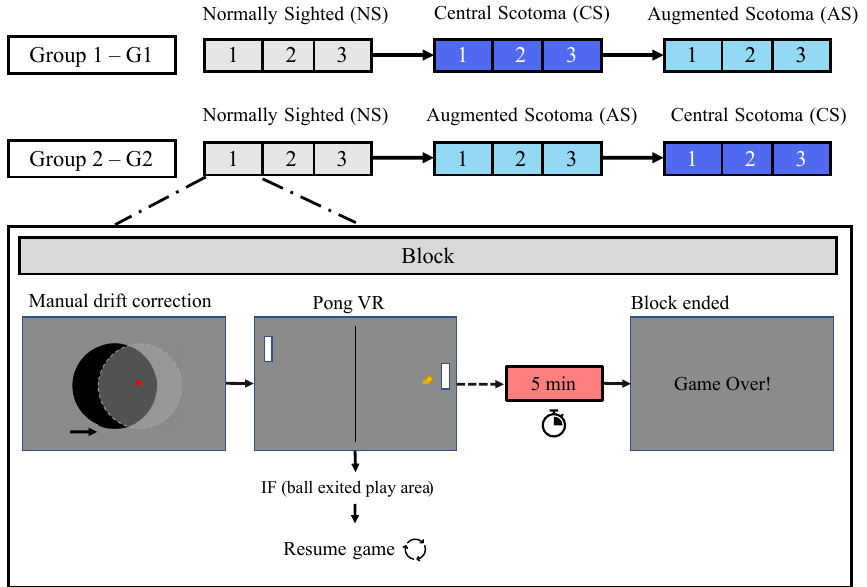
Figure 3. Scheme of the experimental procedure. Participants were divided into two groups (G1 and G2). Both groups initiated playing the Pong game under normal vision conditions (normally sighted, NS). The difference between groups was defined by the order by which the scotoma (CS) and augmented scotoma (AS) simulations were presented. In group 1, the scotoma simulation followed the augmentation, in group 2 the opposite. During each condition, three blocks (1, 2, and 3) were tested. Each block was the same for all conditions. It started with a manual drift correction followed by a 5-min timer playtime. During the game, the ball could have exited the play area. In that case, the timer was frozen and the game re-started. When the timer ended, a new block